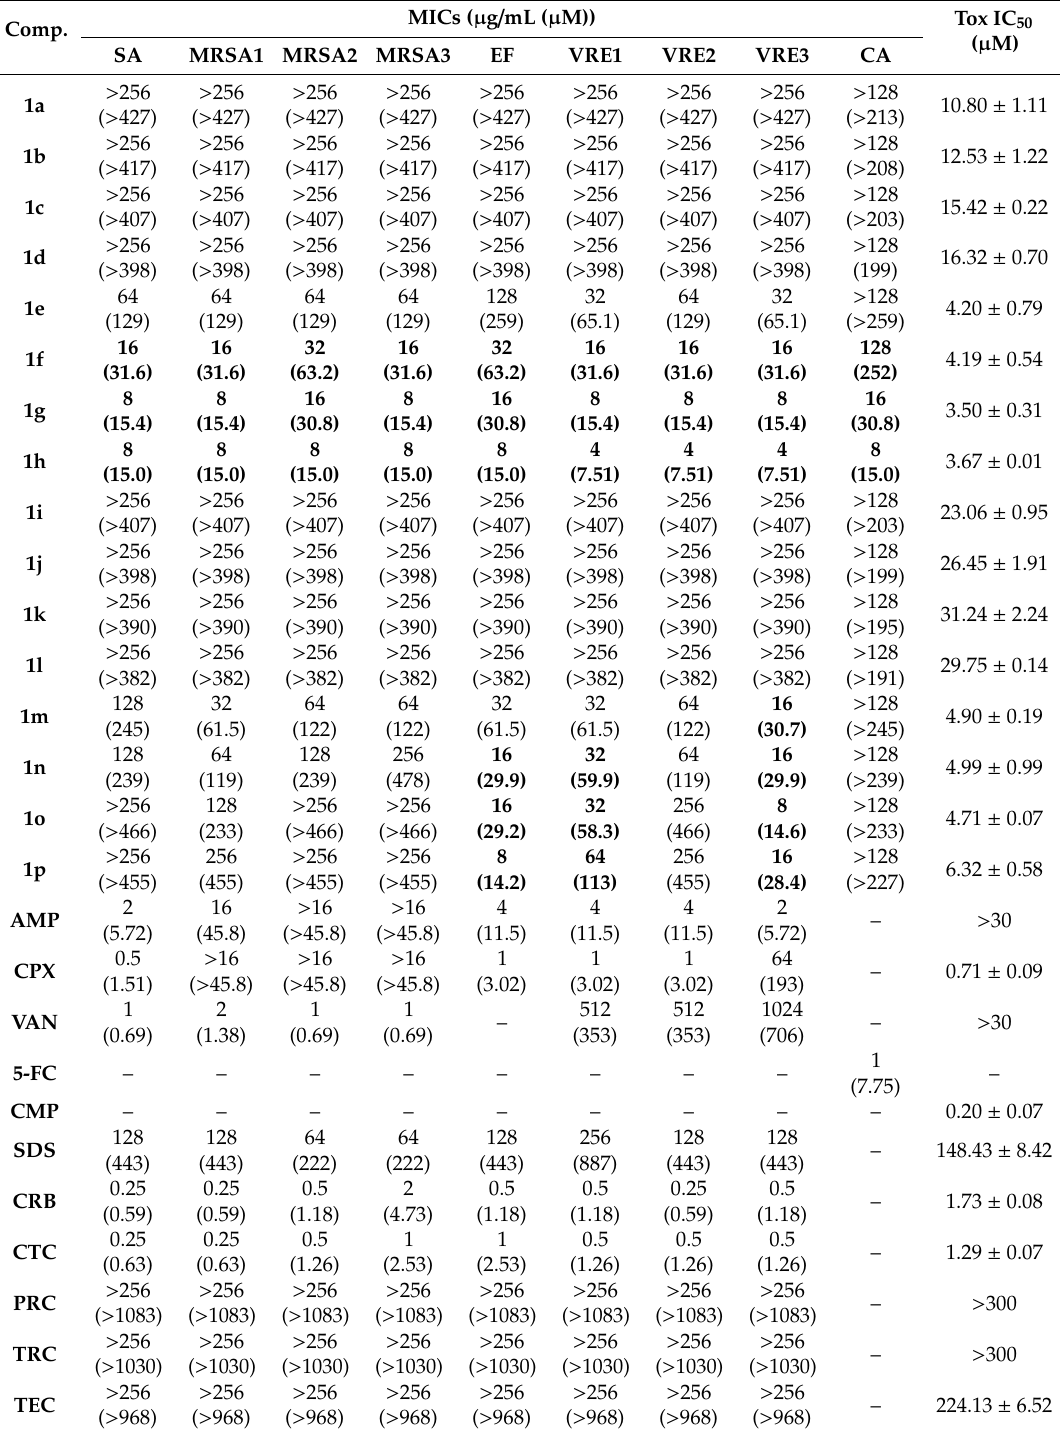
Table 2. In vitro minimum inhibitory concentrations (MICs, µ g / mL ( µ M)) of compounds 1a – 1p against tested microbial strains compared to control agents and in vitro antiproliferative (Tox) data (IC 50 ( µ M)) compared to